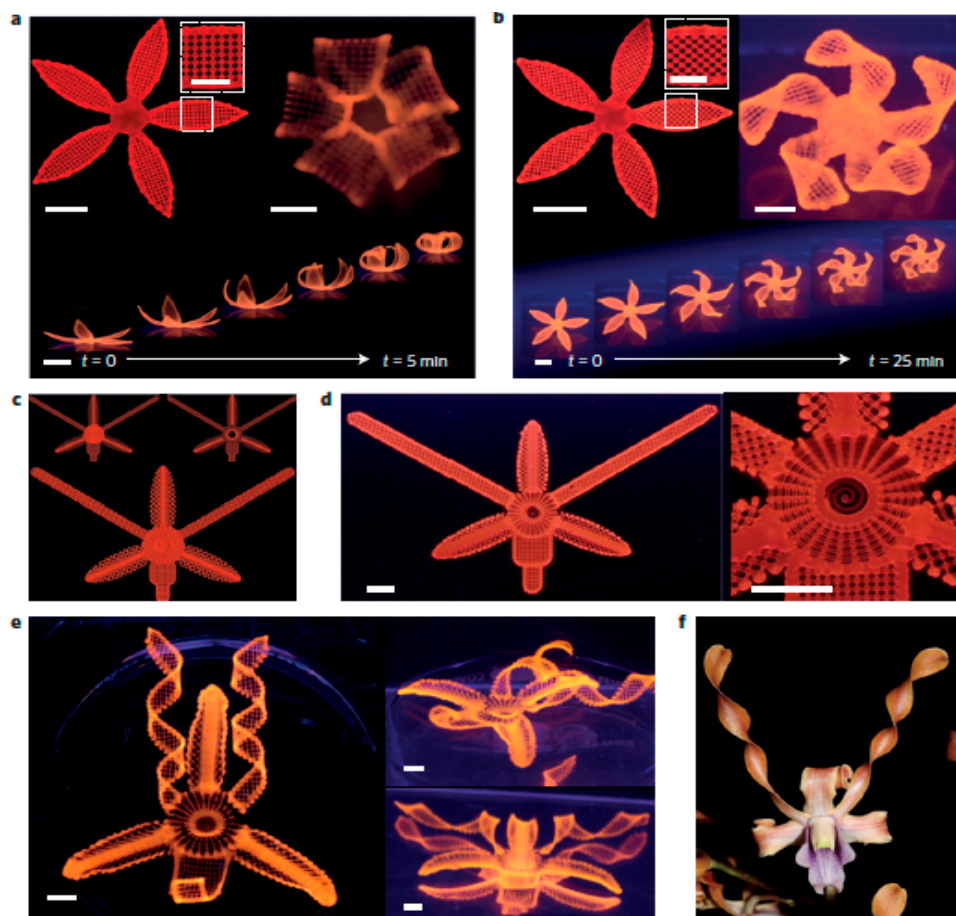
Figure 5. Complex flower morphologies generated by biomimetic 4D printing. ( a , b ) Simple flowers composed of 90 ◦ /0 ◦ ( a ) and 45 ◦ /45 ◦ ( b ) bilayers oriented with respect to the long axis of each petal, with time-lapse sequences of the flowers during the swelling process (bottom panel) (scale bars, 5 mm, inset = 2.5 mm). ( c – f ) Print path ( c ), printed structure ( d ) and resulting swollen structure ( e ) of a flower demonstrating a range of morphologies inspired by a native orchid, the Dendrobium helix ( f ). Based on the print path, this orchid architecture exhibits four different configurations: bending, twisting and ruing corolla surrounding the central funnel-like domain (scale bars, 5 mm). Reprinted by permission from [208] published by Springer Nature.